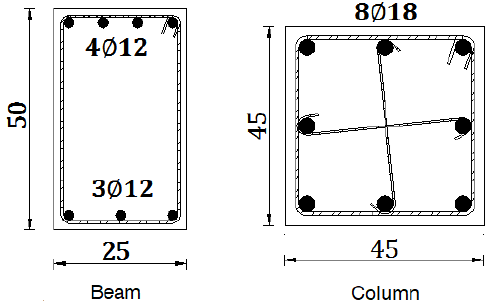
Figure 6. Cross-sections of columns and beam support.